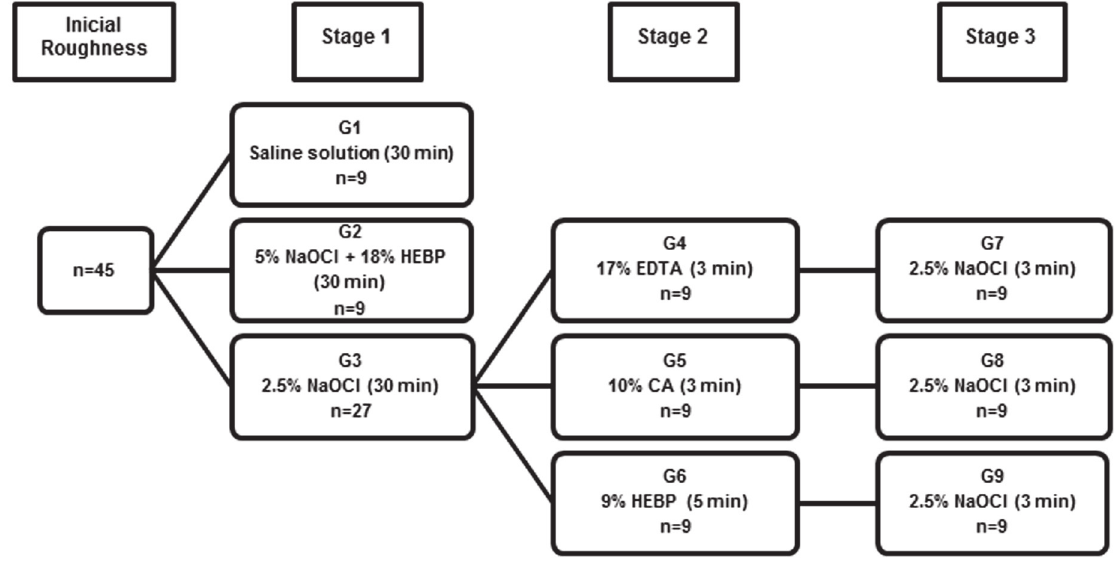
Figure 1- Experimental Table 1- Median (Med) and interquartile range (IQR) and P values (Wilcoxon test) for roughness analysis in the cervical third before (T0) and after (T1) the application of the irrigation regimens